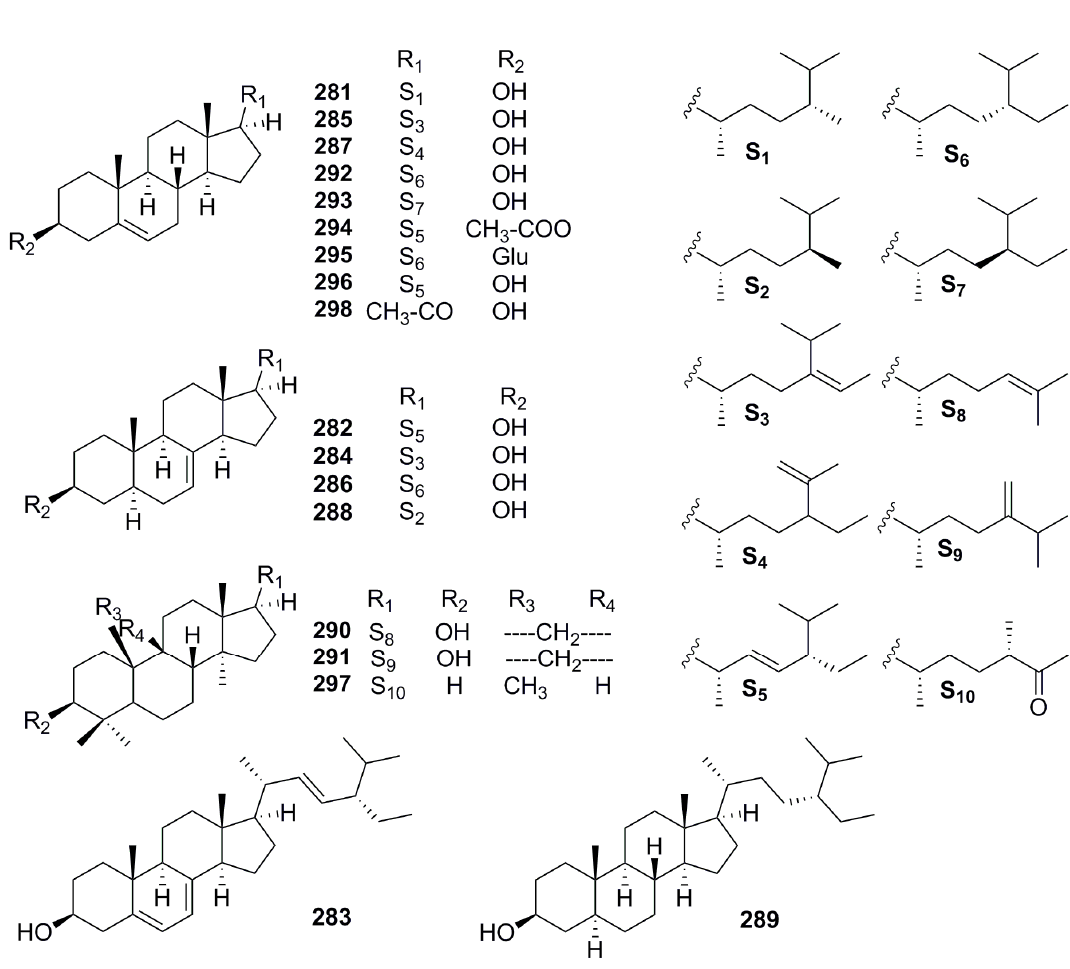
Figure 7. Chemical structures of sterols.